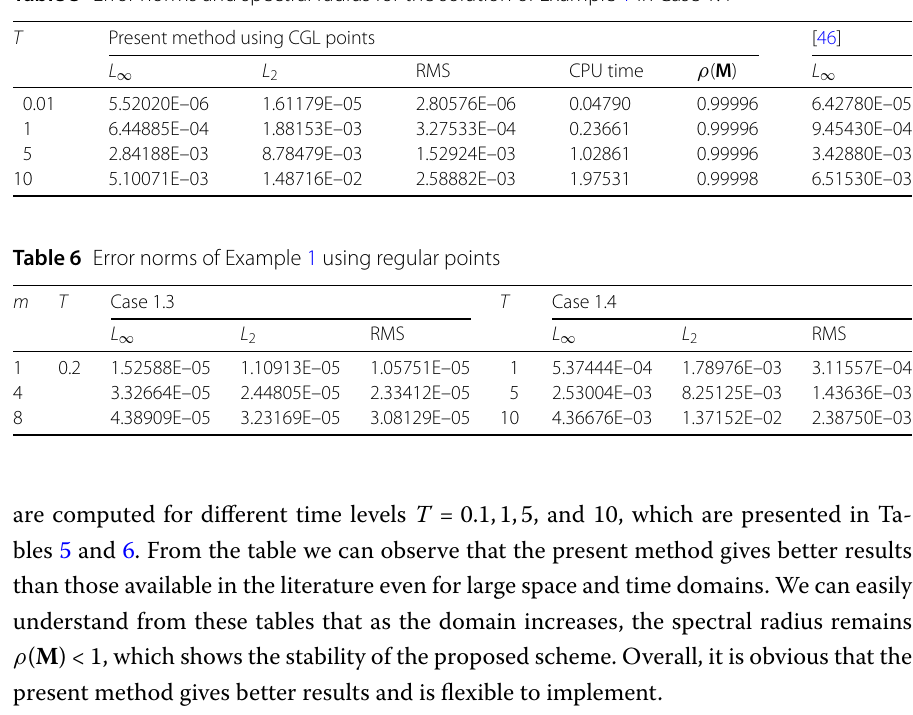
Table 5 Error norms and spectral radius for the solution of Example 1 in Case 1.4